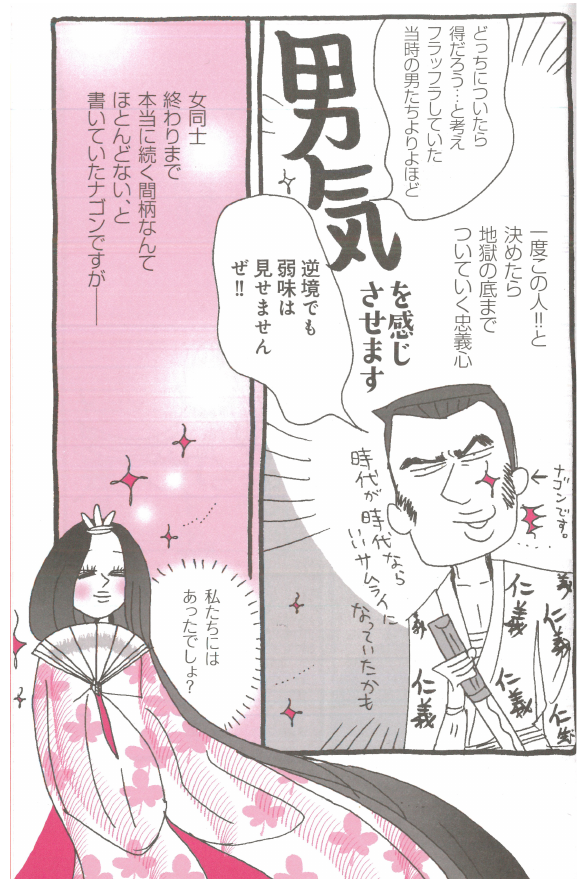
Figure 8. Sei appears as a member of the yakuza . Yumiko Comukai, Honjitsu mo ito okashi Makura no sōshi (Tokyo: Kadokawa, 2014), 175. (Courtesy of Kadokawa)